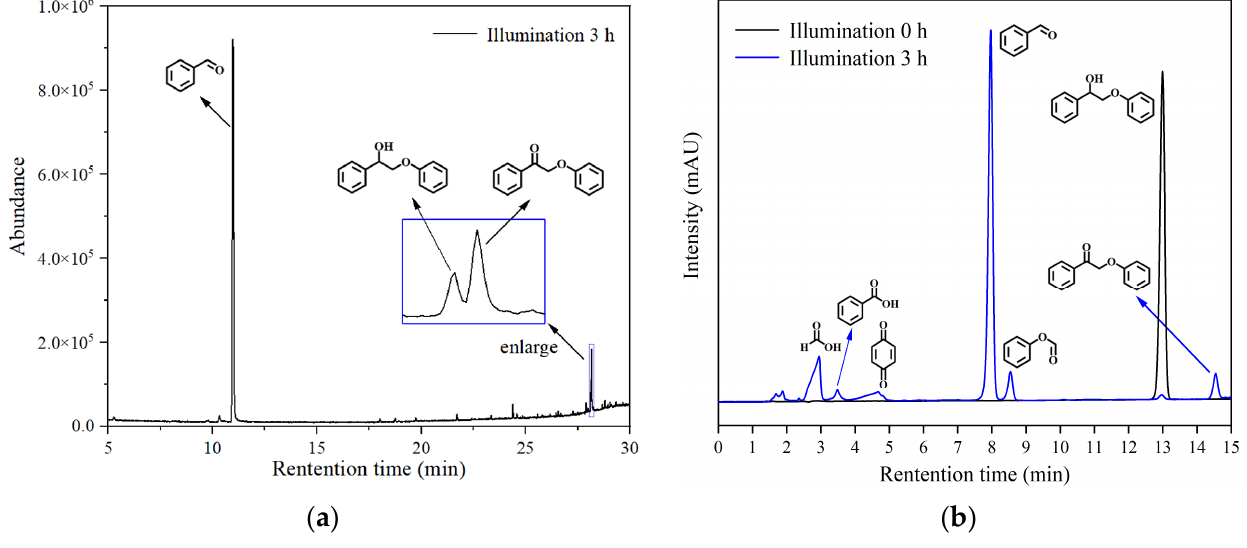
Figure 7. Overall GC-MS ion-flow diagram ( a ) and HPLC ( b ) of photocatalytic products of ML.